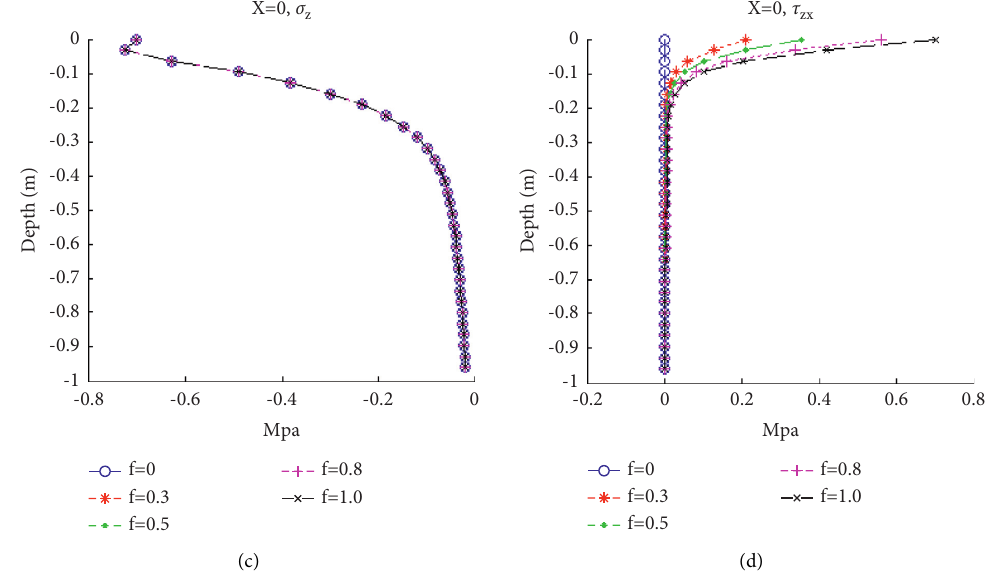
Figure 14: Calculation results of normal stress and shear stress in z -axis ( x � 0) at center point of single circular load. (a) Calculation results of normal stress σ x in z -axis ( x � 0) at center point of single circular load. (b) Calculation results of normal stress σ y in z -axis ( x � 0) at center point of single circular load. (c) Calculation results of normal stress σ z in z -axis ( x � 0) at center point of single circular load. (d) Calculation results of shear stress τ zx in z -axis ( x � 0) at center point of single circular load.